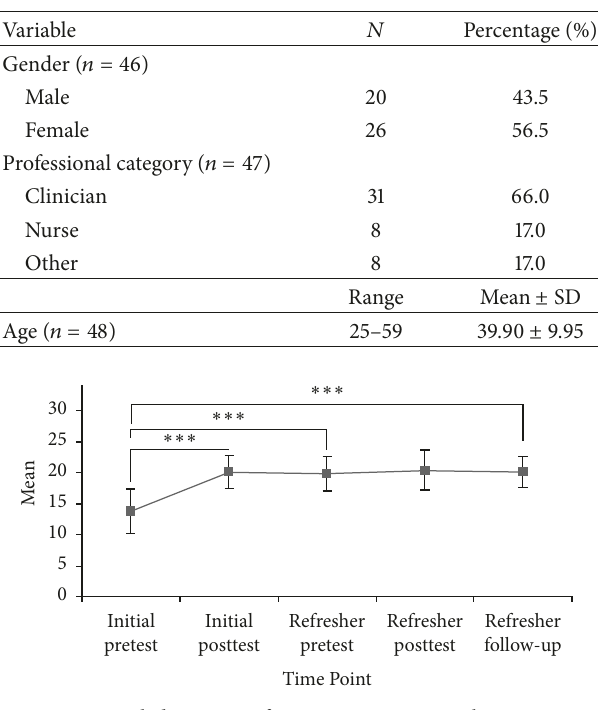
Figure 1: Knowledge scores of HCP over time. Error bars represent ± 1 SD. ∗∗∗ 𝑝 ≤ 0.001 . categories, “clinicians” included clinical officers and senior